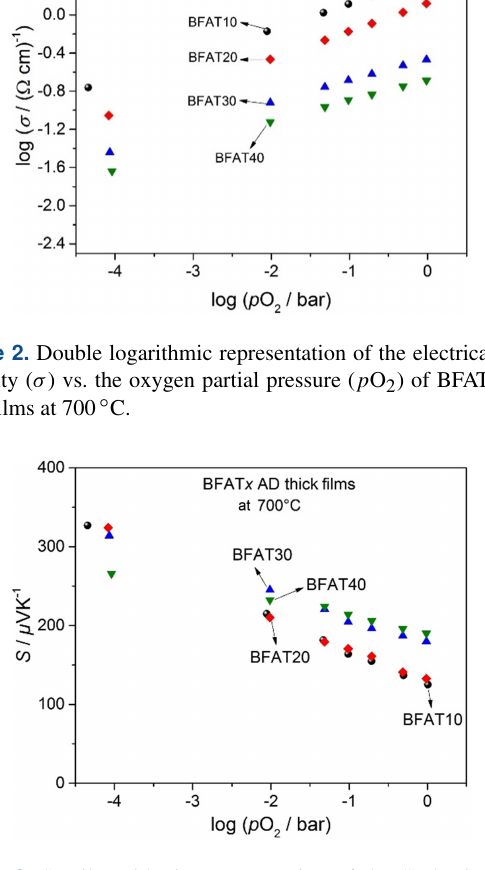
Figure 3. Semilogarithmic representation of the Seebeck coeffi- cient S and the oxygen partial pressure p O 2 of BFAT x AD thick films at 700 ◦